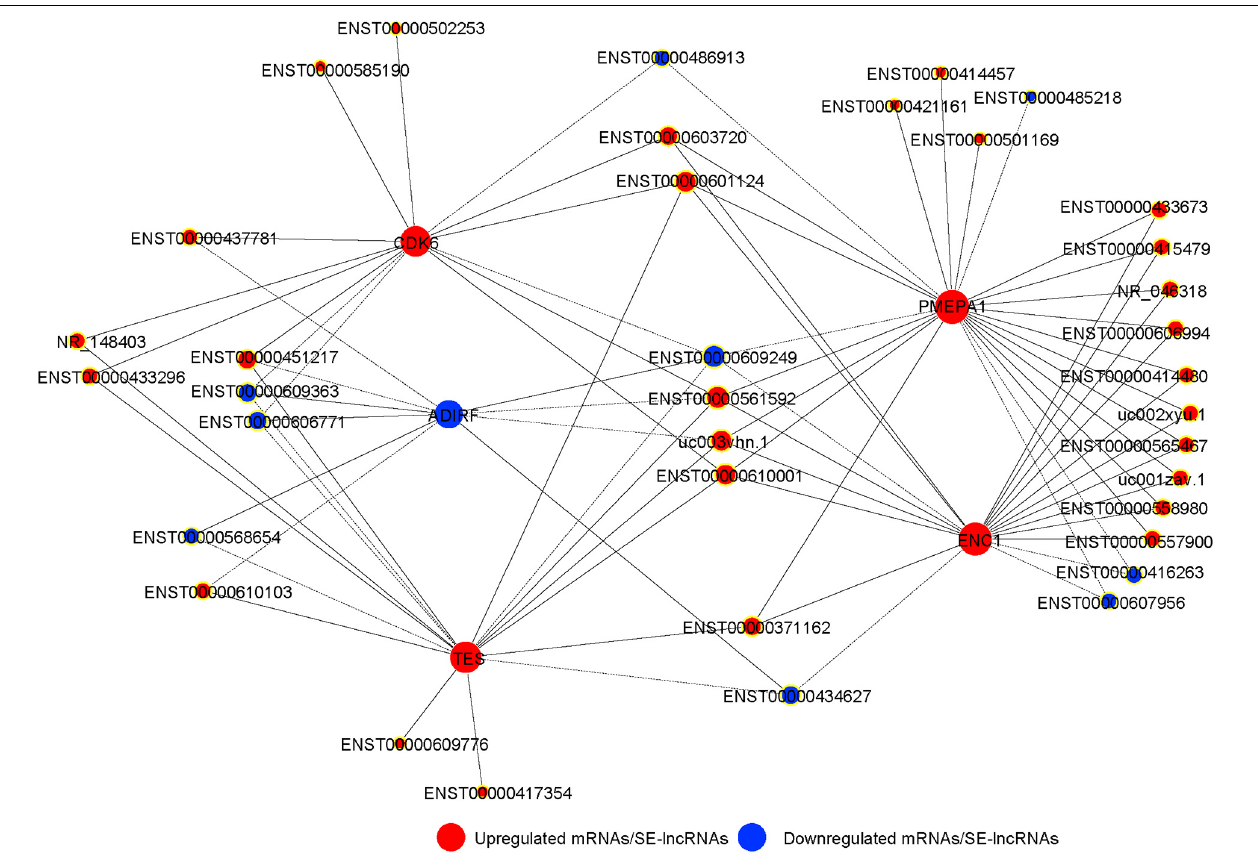
FIGURE 6 | The co-expression network of SE-lncRNAs and mRNAs during chondrogenic differentiation of BMSCs. The nod with a yellow border represents lncRNA, and the nod without yellow border is mRNAs. Red represents upregulated SE-lncRNA/mRNA, and blue represents downregulated SE-lncRNA/mRNA, respectively. Connections of nods show the regulatory role between mRNAs and SE-lncRNAs. Solid lines indicate the positive correlation, and dashed lines indicate the negative